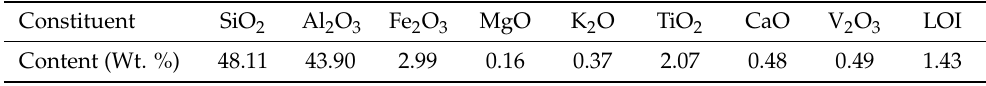
Table 1. Chemical composition of